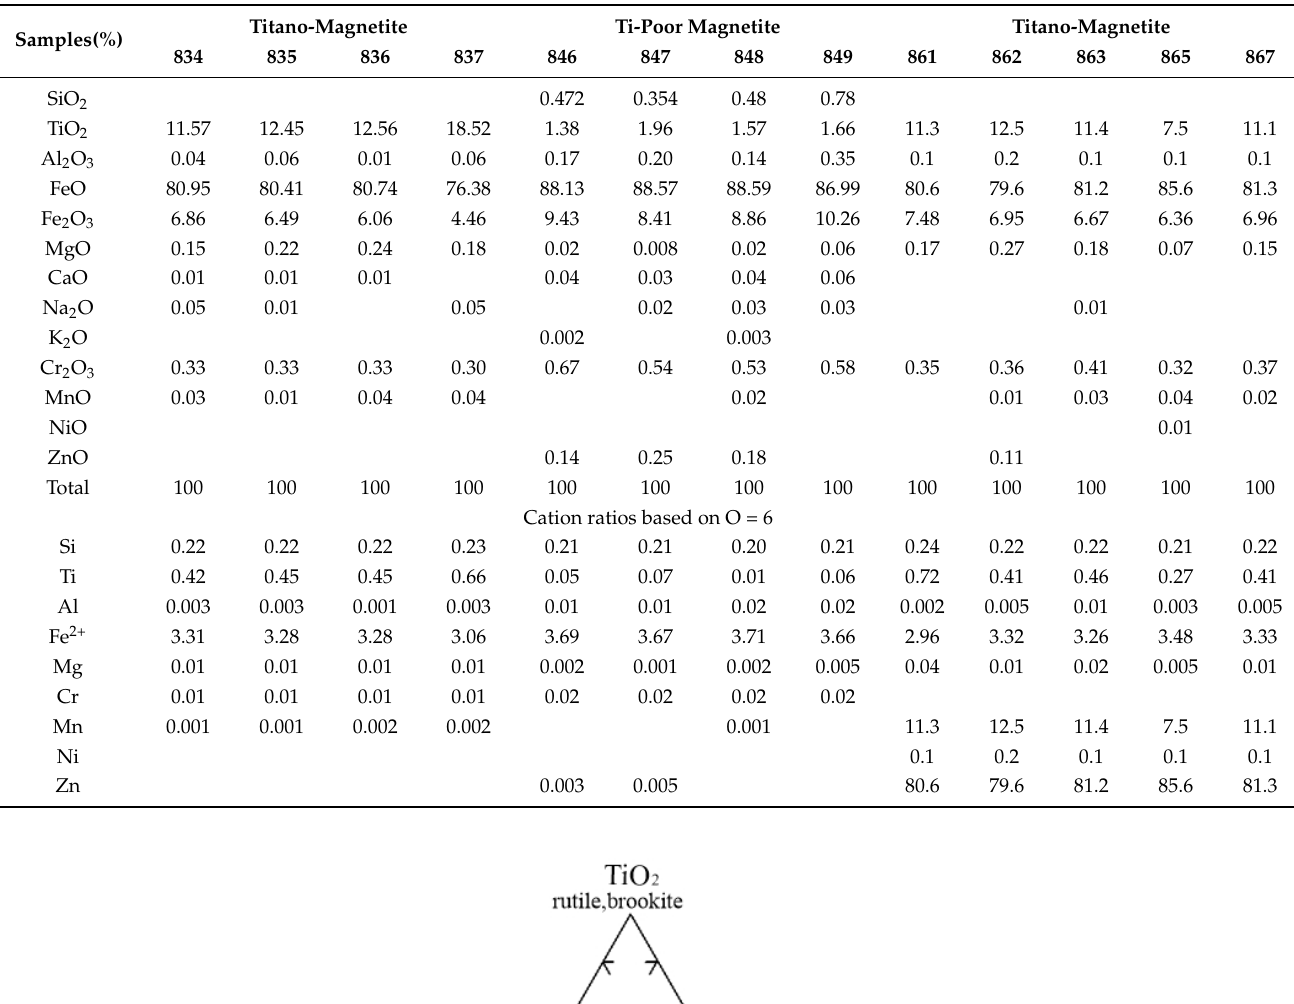
Table 4. Representative electron microprobe analyses of titano-magnetite from the Abu Ghalaga mine, Egypt (all values are in wt.%).